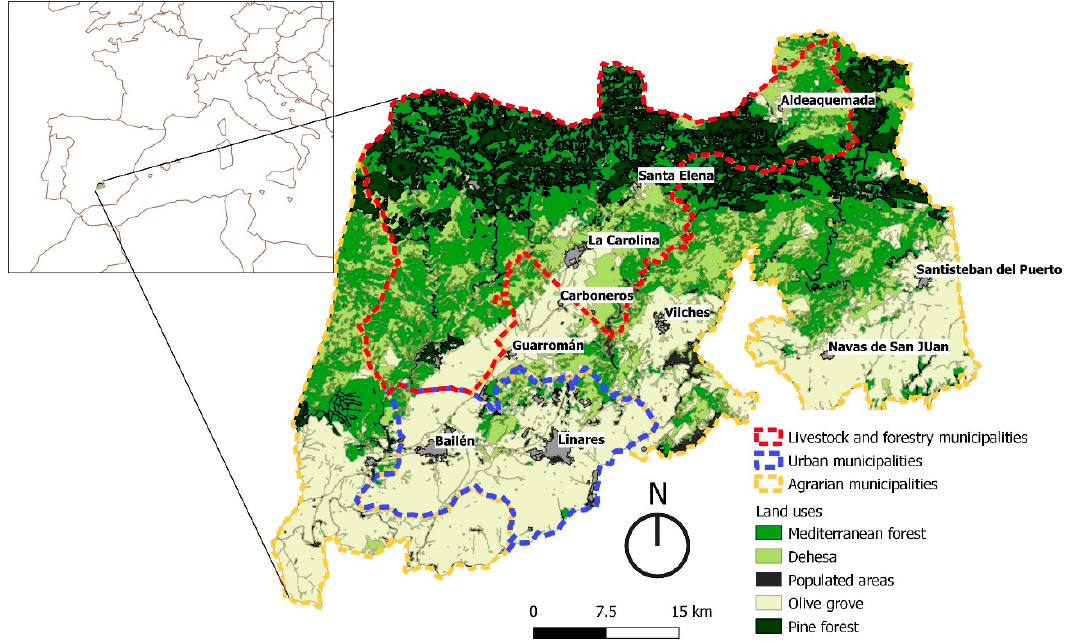
Figure 1. Social-ecological sectorization of the study area and land uses. Source: Information network of Andaluc í a